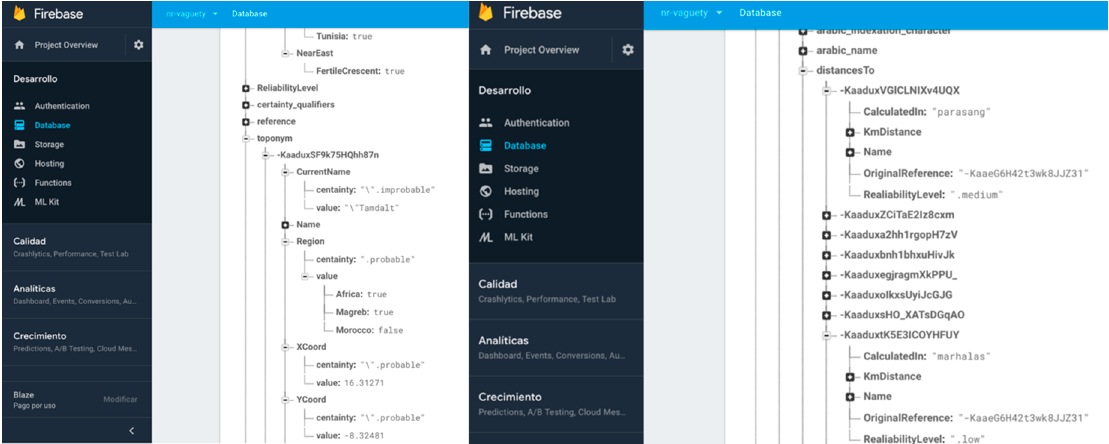
Figure 7. Firebase console showing final implementation details. At right, the values marhalas or parasangs (Iranian past measure unit for distance) as vague measurement units for distance in the DICTOMAGRED data model. At left, the final values for the specific Tamdalt toponym supporting vague information .